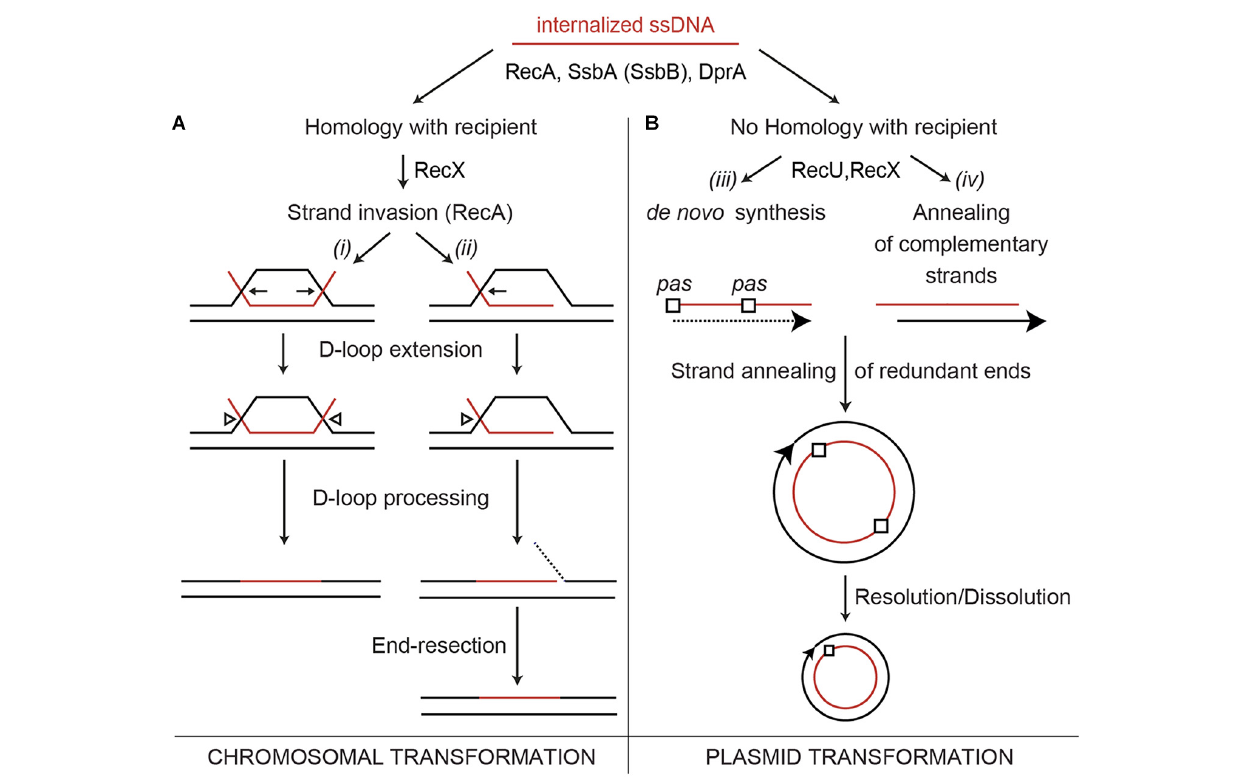
FIGURE 1 | Chromosome and plasmid transformation. The DNA uptake apparatus, built at one of the cell poles, internalizes one of the strands as linear ssDNA. (A) During chromosomal transformation DprA (or RecO in the (cid:49) dprA context in vivo ) loads RecA onto SsbA (or SsbA and SsbB)-coated ssDNA. During the homology search, the RecA filament length is modulated by RecX. (Ai,ii) , a RecA nucleoprotein filament catalyzes DNA strand invasion. Then, the D-loops are extended (denoted by pointing arrows), and an uncharacterized resolvase cleaves the displaced strand (arrow head), which is then degraded. (B) RecA filaments form on the internalized oligomeric plasmid ssDNA. RecA inhibition by RecU or RecX facilitates the conversion of the ssDNA into its duplex form via DNA synthesis (initiated at the primosome assembly site, pas ) to generate a strand with the opposite polarity (broken line) (Biii) or via annealing of the two independently internalized complementary strands (Biv) . Then, the annealing of the terminal redundant DNA ends allows circularization of the oligomeric plasmid DNA (Biii,iv) . In a final step, the oligomeric plasmid molecule is converted into a